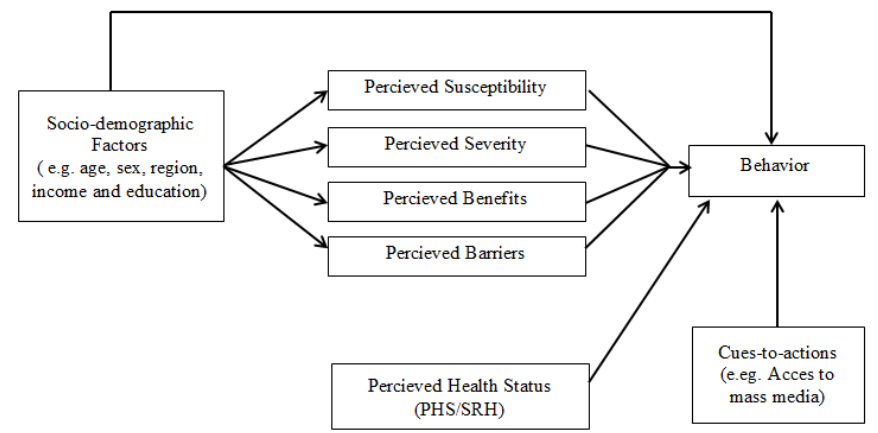
Figure 1. Variables included in the